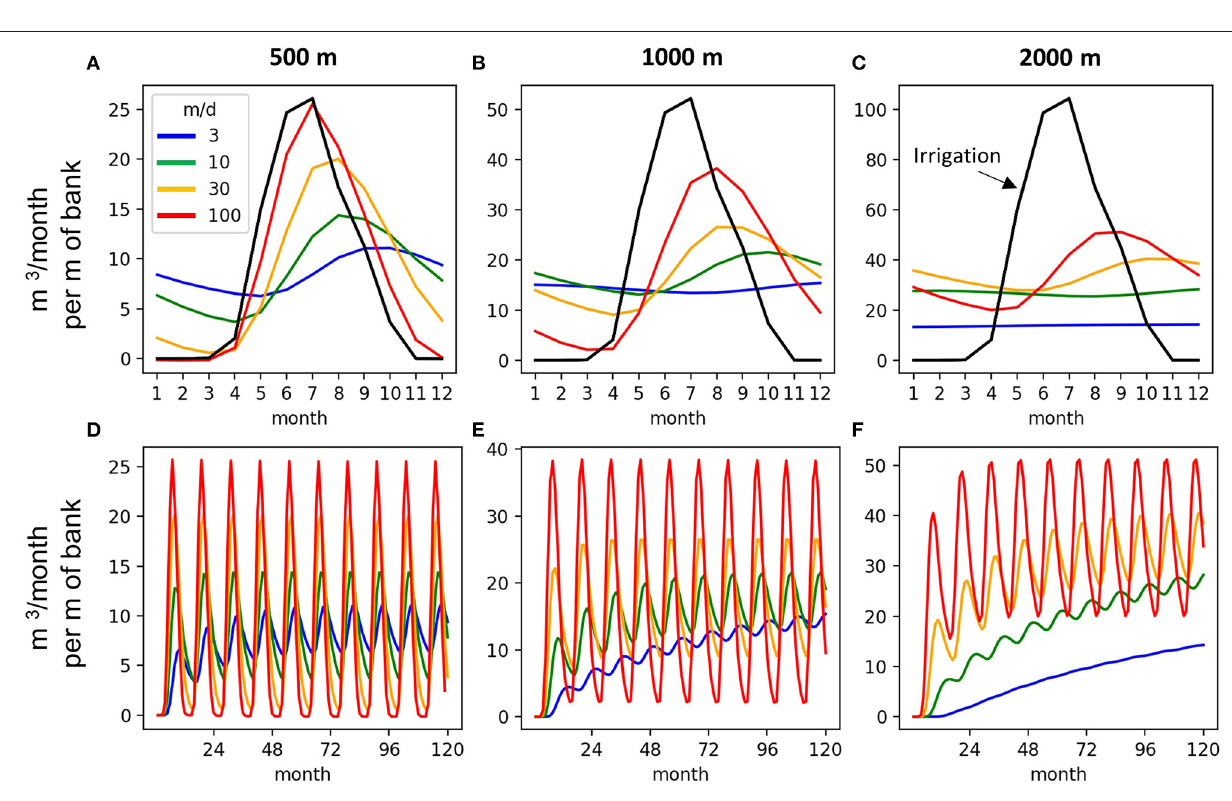
line are illustrative of general deviations of the analytical solution from the modeled return flows for each aquifer width and K scenario (plotting the corresponding analytical solution for all six combinations of b and Sy would make Figure 6